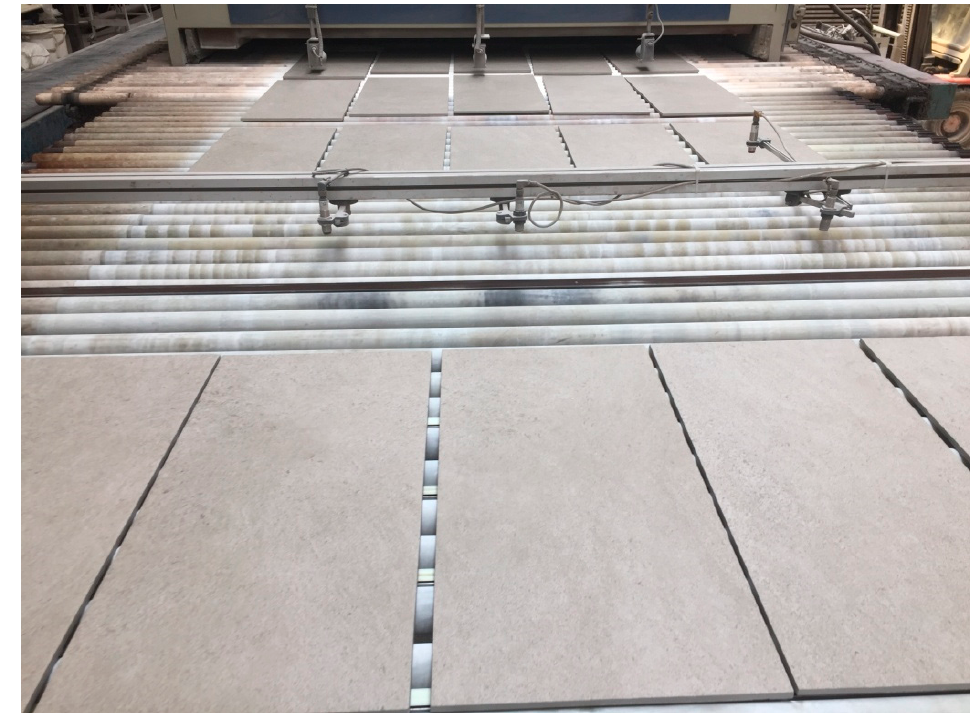
Figure 7. Industrial production of 30 cm × 60 cm tiles.